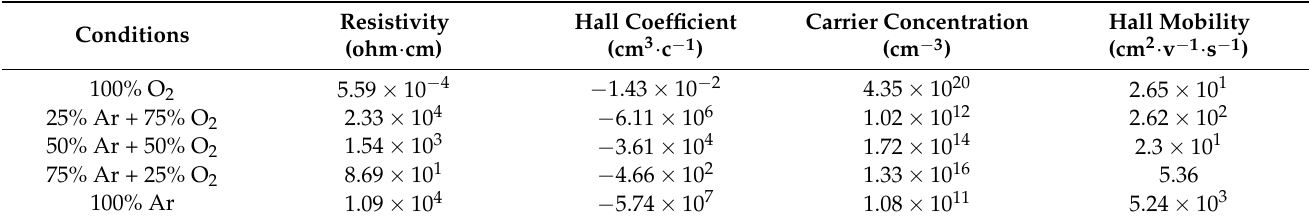
Table 2. The result of Hall measurement of IGZO thin film at different deposition